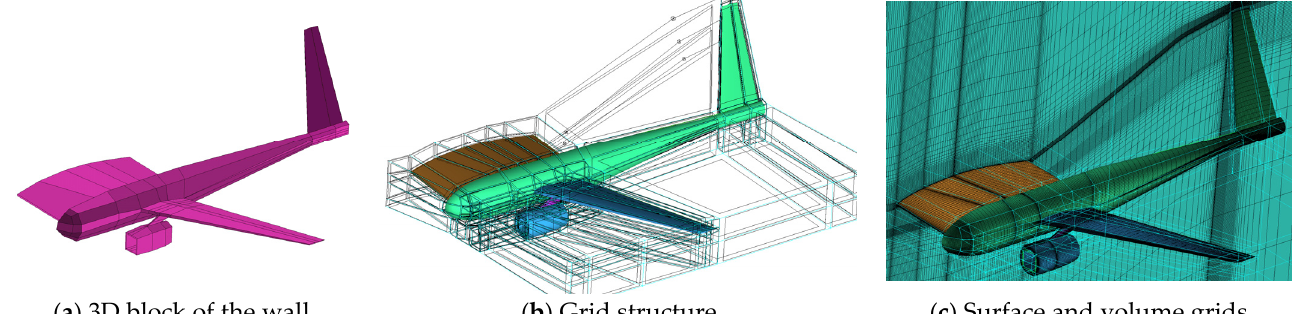
Figure 2. Grid generation